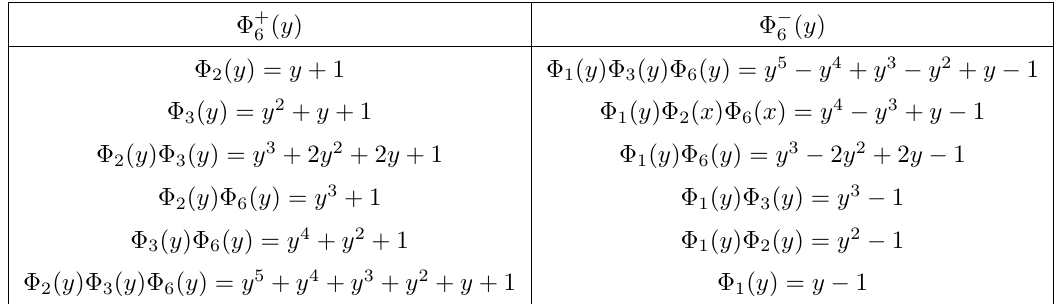
( y ) and n ( y ) = ( y n (cid:0) 1) = (cid:8) + ( y ) for n = 6. n n